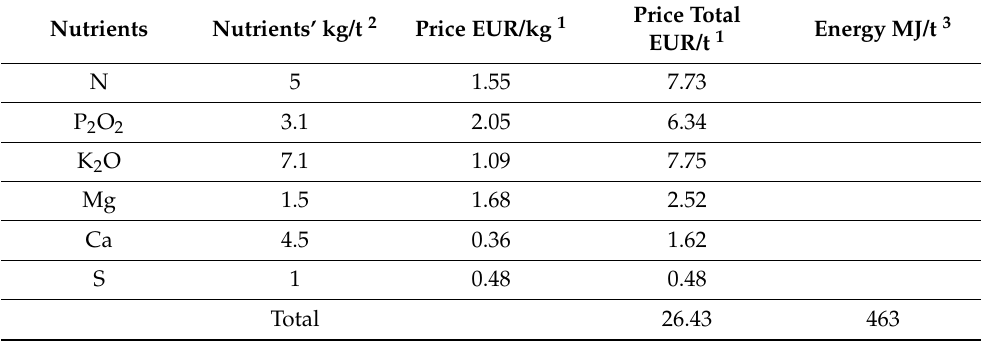
Table A5. Price and energy of nutrients in cow manure.